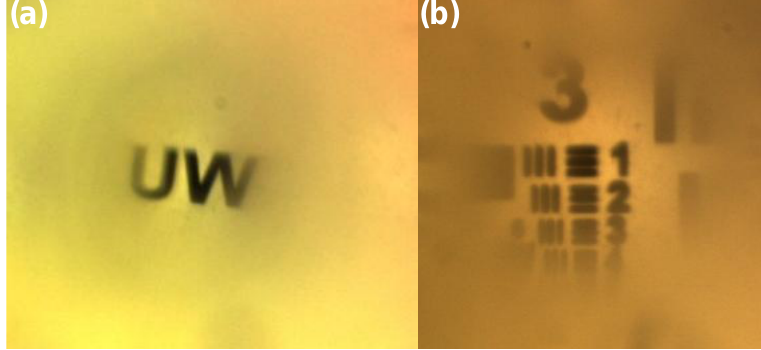
Figure 7. Images under the 0.7-mm PDMS microlenses. ( a ) Shows an image of an inverted “UW” under a 0.7-mm microlens. ( b ) Shows an image of the USAF1951 resolution test chart under a 0.7-mm microlens. The microlens can resolve lines in group 3, element 2.